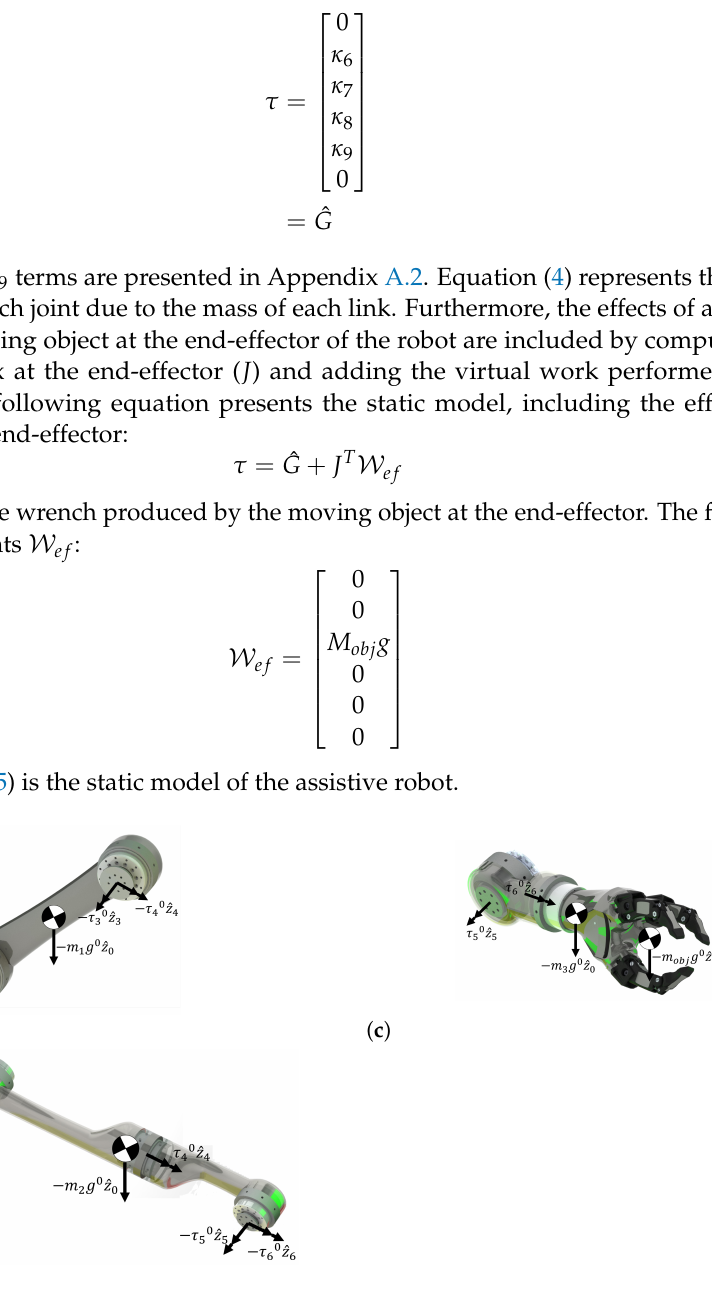
Figure 2. Free body diagrams of the simplified links. ( a ) Link 1, ( b ) Link 2, ( c ) Link